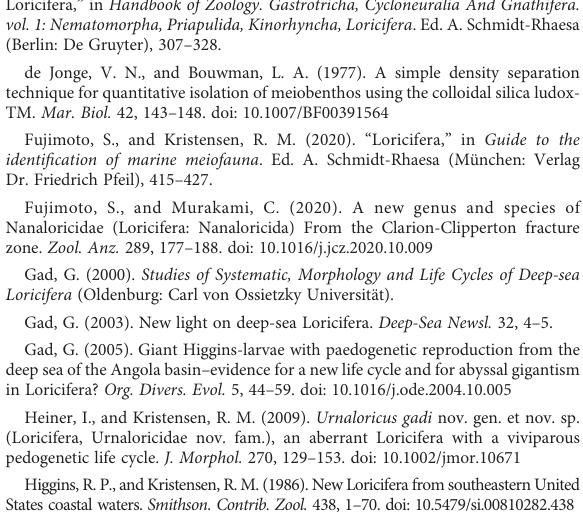
Map showing the sampling localities in the Southern Gulf of Mexico that yielded Loriciferans. The yellow line represents countries limits, whereas the gray line outlines the Mexican Exclusive Economic Zone. Dotted lines represent transects of general sampling of XIXIMI´s cruises. Stations from cruise XIXIMI-6 are represented by black symbols: ■ = Rugiloricus sp., ▲ = Undetermined genus of Pliciloricidae, ● = Undetermined genus of Nanaloricidae. The green symbol represents a station from the cruise XIXIMI-4: ♦ = Pliciloricus sp.